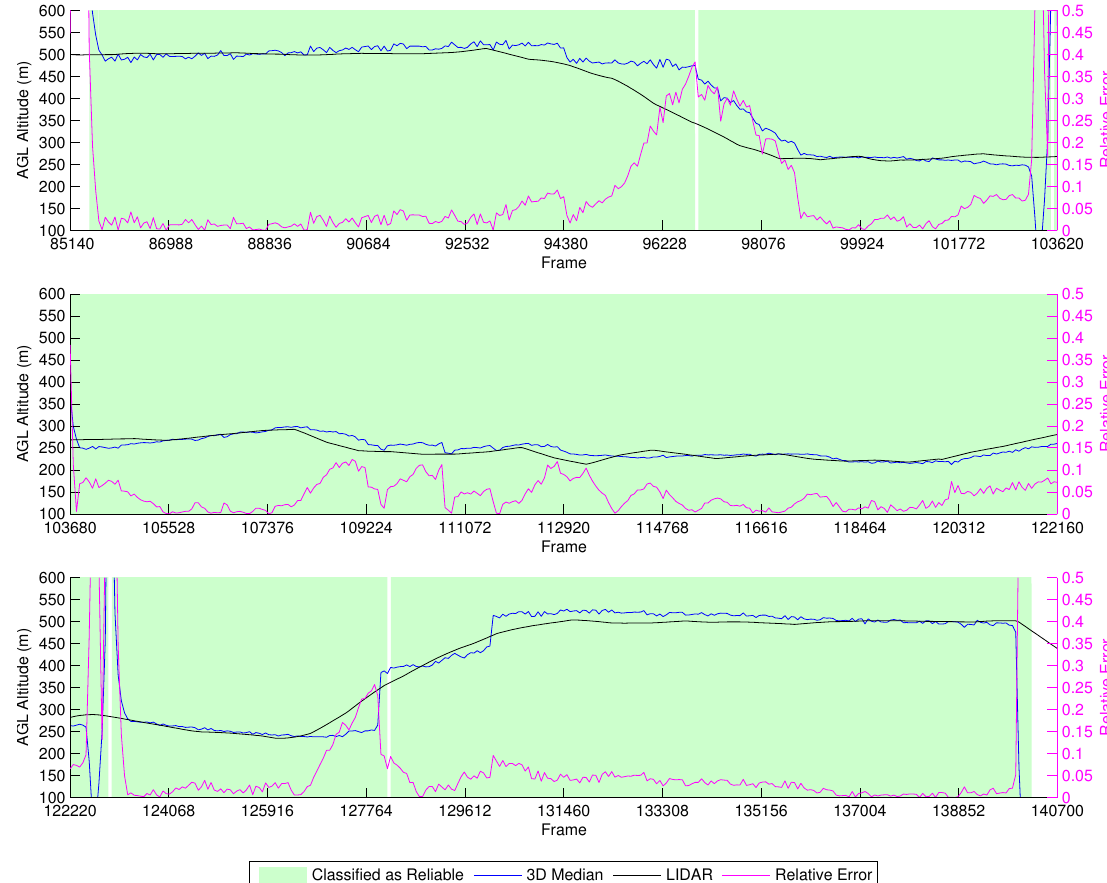
Figure 5. Height estimation results for the fixed ASL altitude at 500 m above the runway